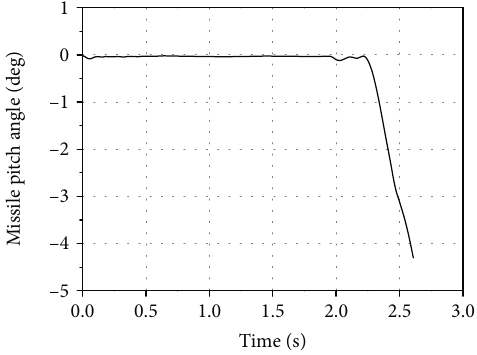
Figure 13: The pitch angle of the missile under a fi xed platform.